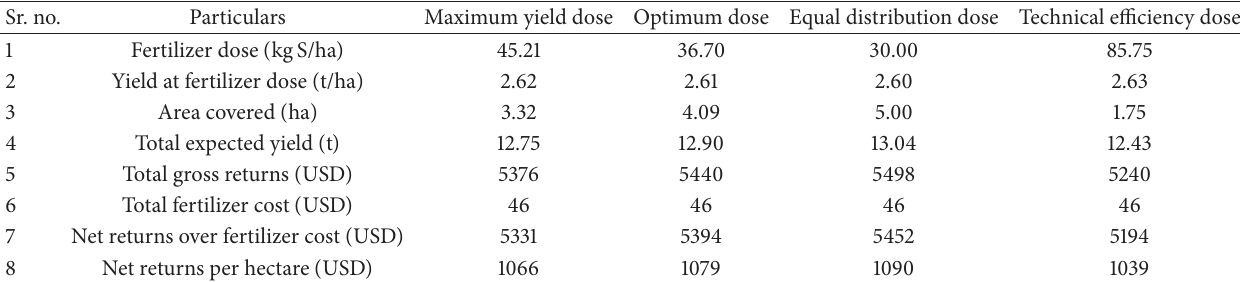
Table 1: Net returns over fertilizer cost under different possibilities of fertilizer use. Sr.